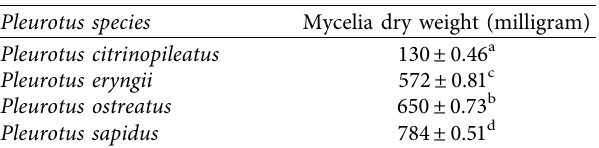
Figure 2: Fruiting bodies of the four Pleurotus species cultivated on coffee wastes (composted coffee husk) in the first flushes. A � P. eryngii, B � P. sapidus , C � P. ostreatus , and D � P. citrinopileatus Table 8: Mycelia dry weight of the four Pleurotus species grown on liquid medium containing pectin as the only carbon source for two weeks.